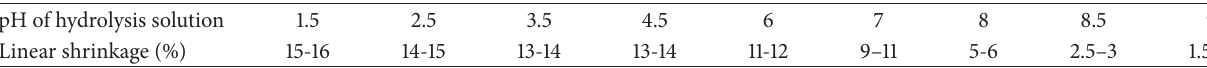
Table 2: Linear shrinkage of 18% TEOS aerogels versus the pH of hydrolysis.